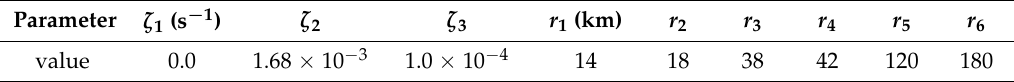
Table 1. Parameters for the basic state relative vorticity